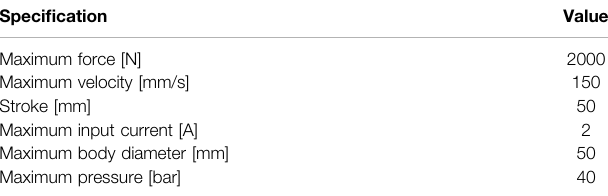
TABLE 11 | 2DoF MR Damper technical speci fi